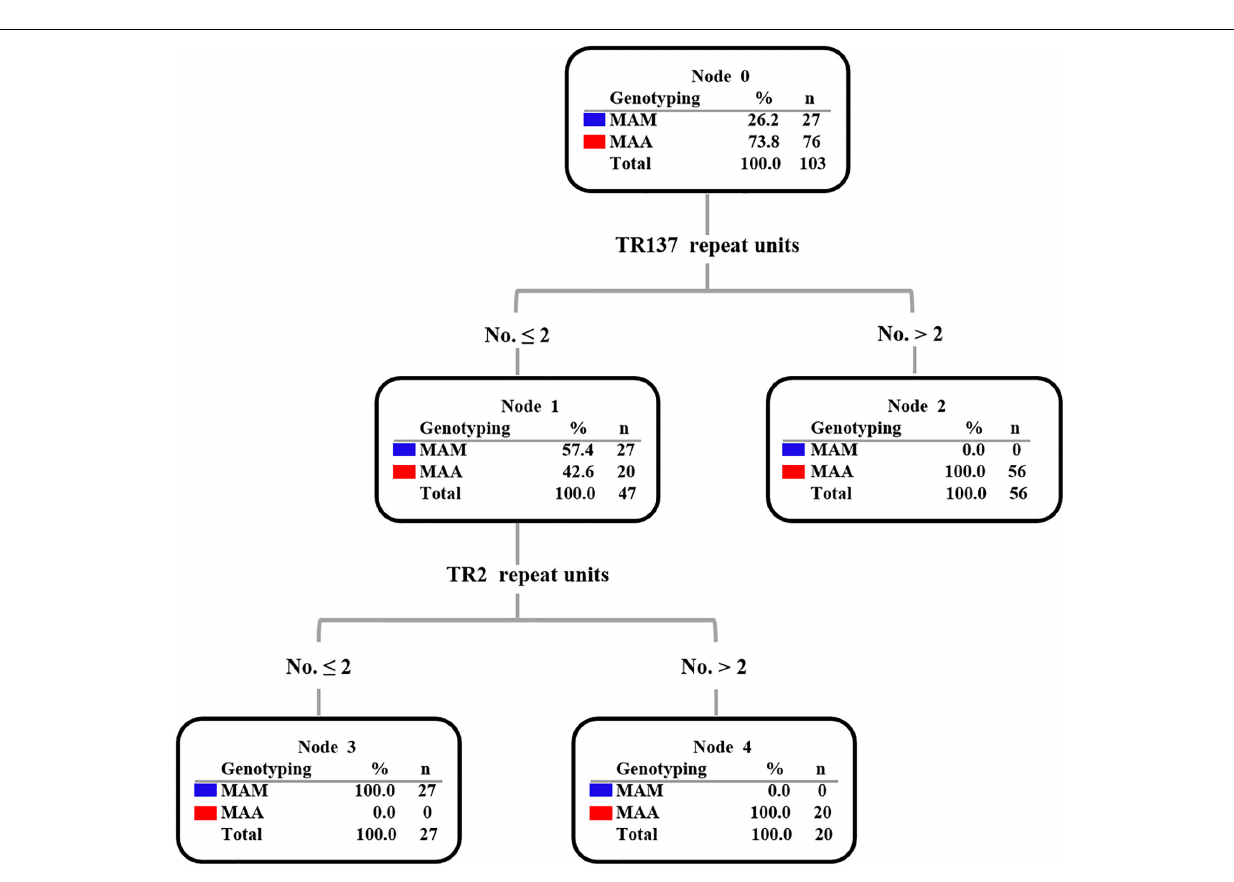
Frontiers in Microbiology |